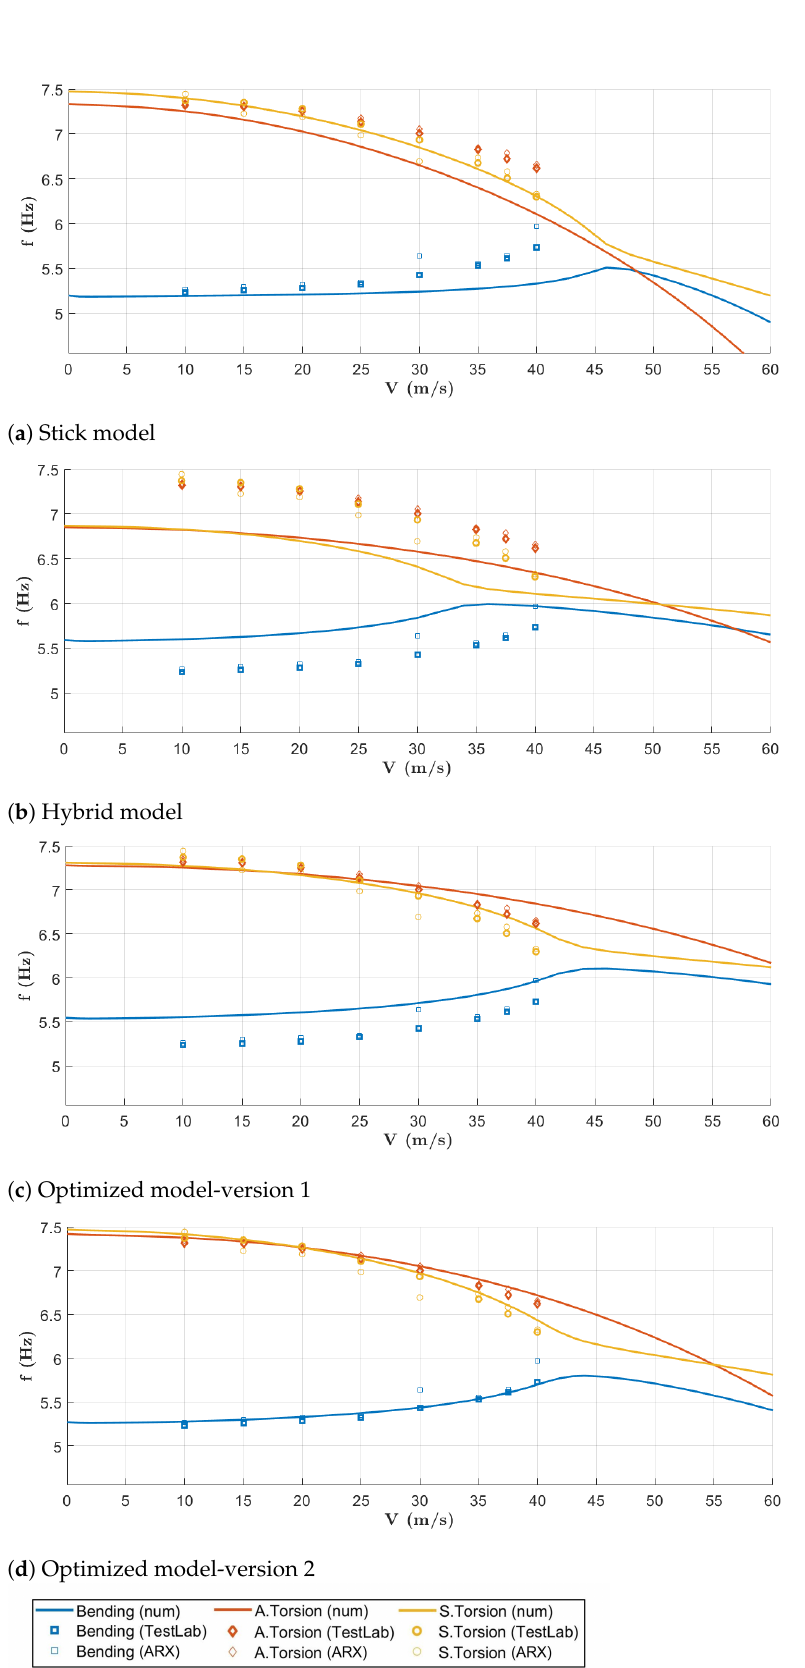
Figure 15. V − f plots of the mass-backward